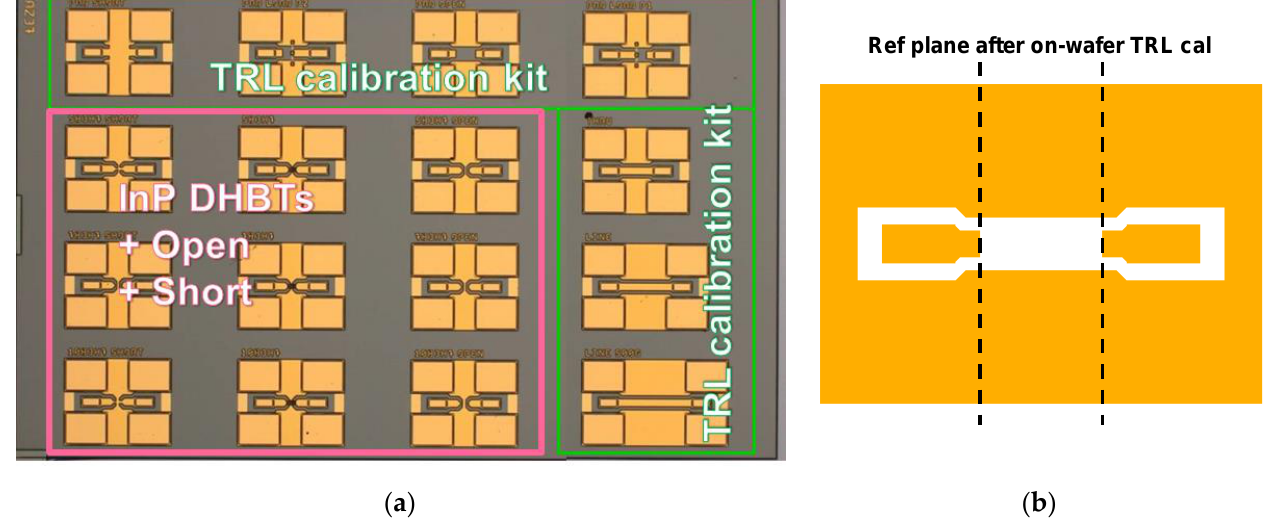
Figure 12. ( a ) InP DHBT test structures for measurements beyond 110 GHz; ( b ) Layout view of the Pad-Open.